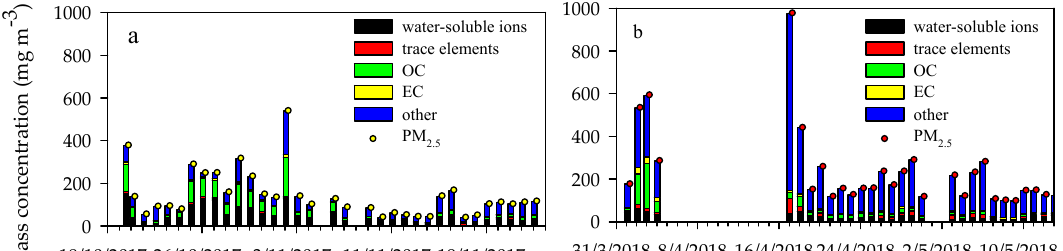
Figure 4. Daily variations of PM 2.5 mass concentration, organic carbon (OC), elemental carbon (EC), water-soluble ions, and trace elements. ( a ) Daily variations of PM 2.5 mass concentration, organic carbon (OC), elemental carbon (EC), water-soluble ions, and trace elements in Autumn 2017. ( b ) Daily variations of PM 2.5 mass concentration, organic carbon (OC), elemental carbon (EC), water-soluble ions, and trace elements in Spring 2018.